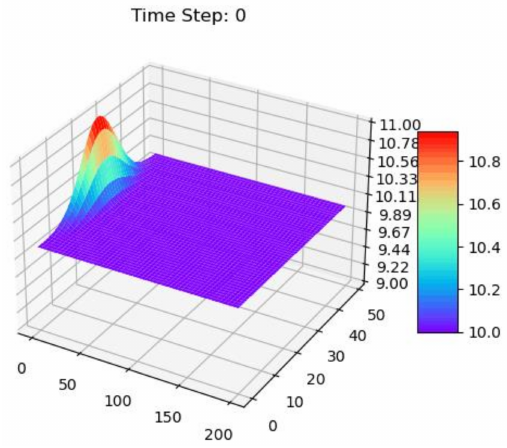
Figure 2. Schematic of a small-scale initial state.